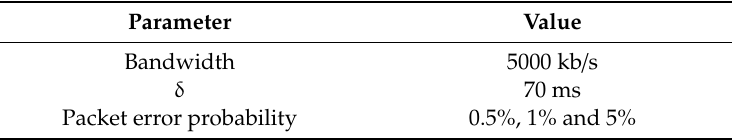
Table 1. Wireless Link emulation Paramenters.